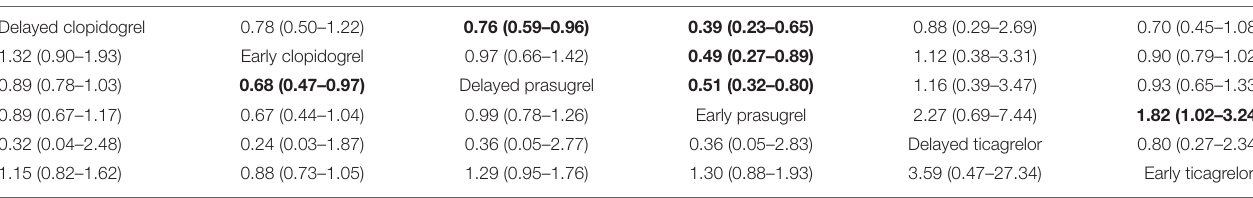
TABLE 3 | League table of the effects of P2Y 12 inhibitors expressed as risk ratio with their 95% CIs on MACE (white cells) and bleeding (gray cells). Delayed clopidogrel